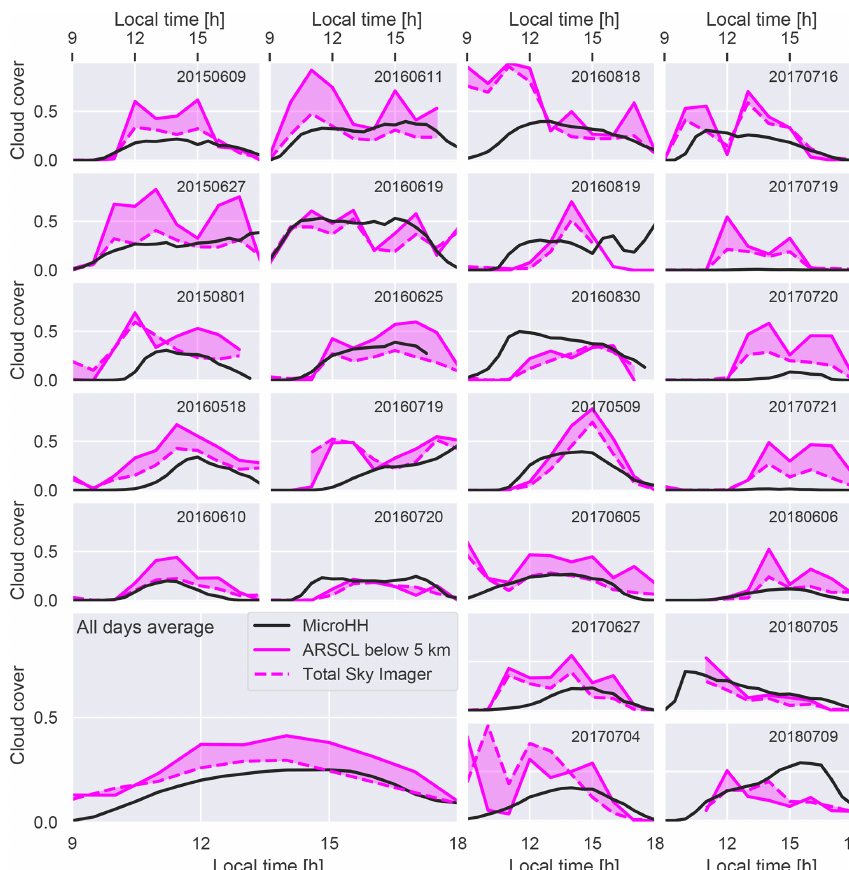
Figure 2. Daily evolution of two cloud fraction measurements provided hourly by the LASSO Bundle Browser, along with the MicroHH cloud fraction over the 25 . 6 × 25 . 6km model domain for 24 of the 28 simulations. The remaining four were not included because the cloud fraction is affected by numerical artifacts at the upper model boundary. The Total Sky Imager detects cloud fraction from a fish-eye image of the sky, while the ARSCL is a value-added product for which cloud fraction below 5km is determined for 15min windows. Observations are only used when the quality flags are ideal. The mean cloud fraction over all days is shown in the bottom